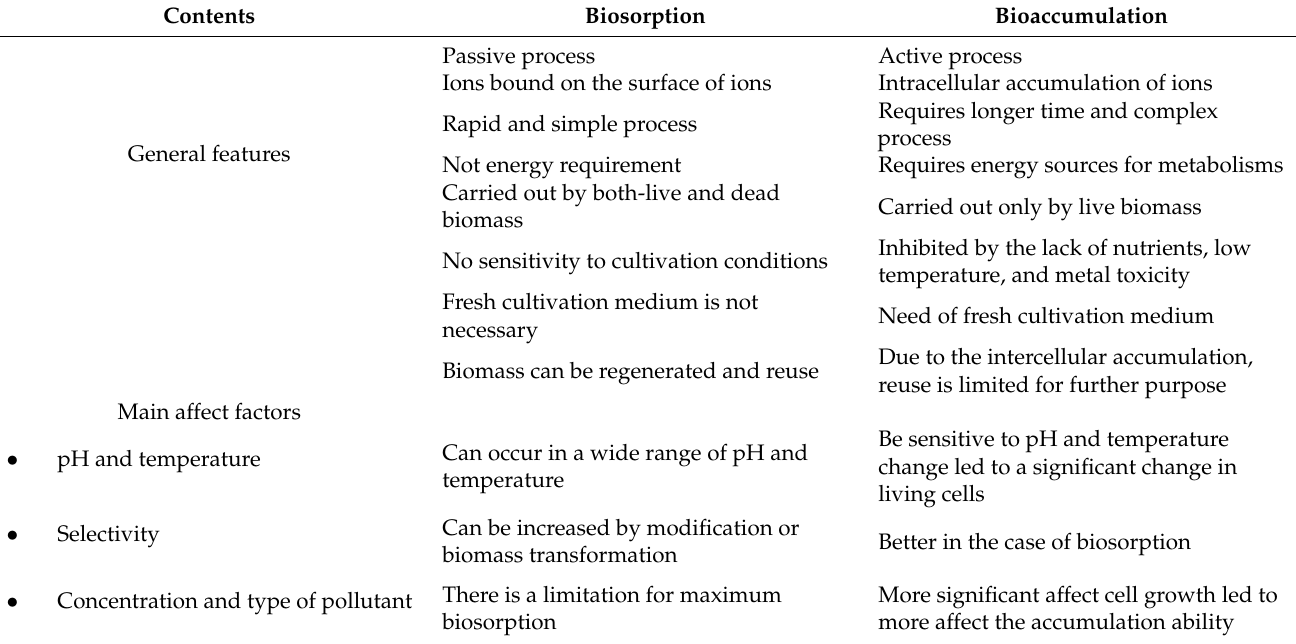
Table 4. Differences between the biosorption and bioaccumulation process of heavy metal removal conducted by bacteria.